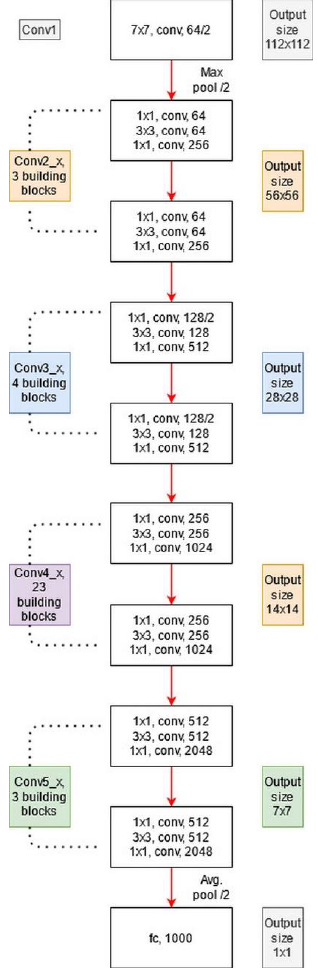
Figure 12. Architecture of ResNet101 pre-trained CNN.